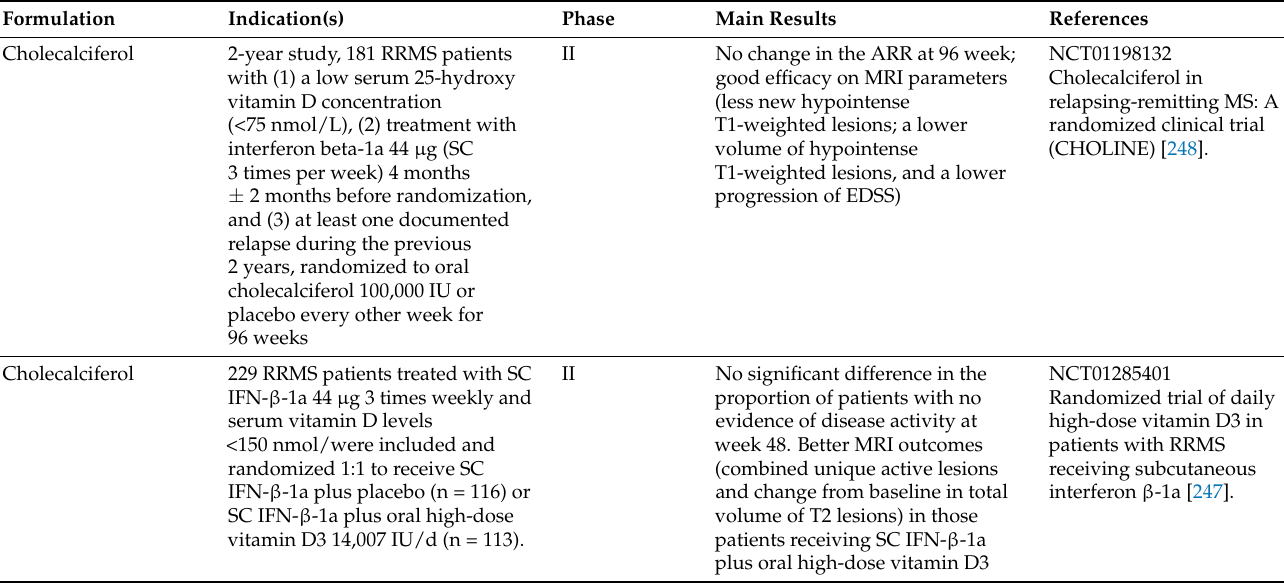
Table 2. Completed clinical trials exploring the effect of vitamin D supplementation in neurological diseases. ALS amyotrophic lateral sclerosis; ARR annualized relapse rate; CIS Clinically isolated syndrome; EDSS Expanded Disability Status Scale; IFN Interferon; IL interleukin; IU International Units; MS multiple sclerosis; ON optic neuritis; QoL quality of life; RNFL retinal nerve fiber layer; RRMS Relapsing Remitting Multiple Sclerosis; SC subcutaneous. To convert 25(OH)D from ng/mL to nmol/L the value is multiplied by